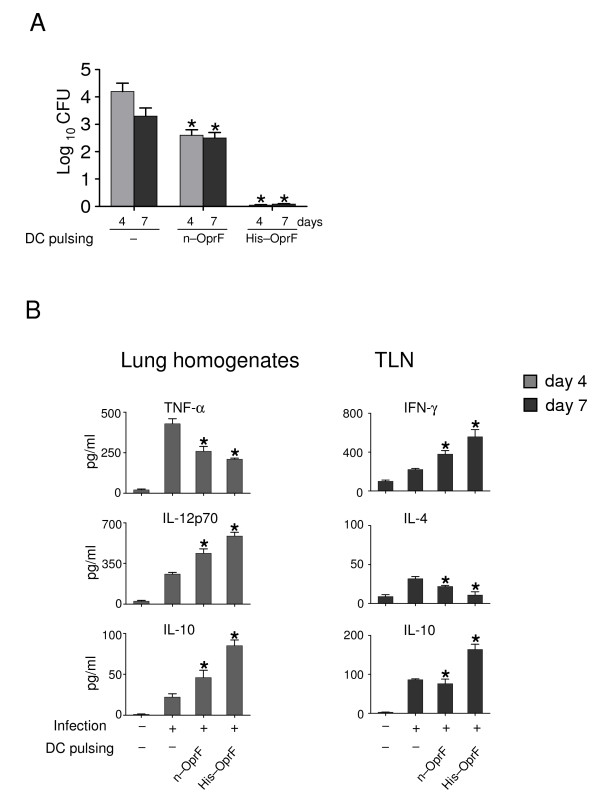
OprF-pulsed DCs protect mice from infection with the PAO1 strain. Splenic 105 dendritic cells (DCs), either unpulsed (-) or pulsed as in legend to figure 1, were administered into recipient mice intraperitoneally a week before the intranasal injection of 3 × 107 P. aeruginosa PAO1 strain. (A) Resistance to infection was assessed in terms of CFU at different days after the infection and (B) cytokine production in lung homogenates and culture supernatants of total cells from TLNs stimulated with plate bound anti-CD3e (2 μg/ml) and anti-CD28 (2 μg/ml) for 72 hours. Results are expressed as mean ± SE. * Indicates P < .05, mice receiving pulsed versus unpulsed (-) DCs. In C, - and + alone indicate uninfected and infected mice, respectively.